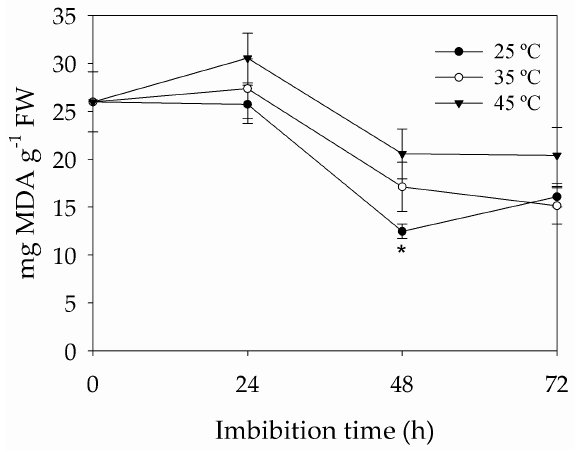
Figure 4. Malondialdehyde (MDA) concentration in Melanoxylon brauna seeds soaked at 25, 35, and 45 °C. * Indicates statistical difference between means. Vertical bars = ± SE, n = 5.